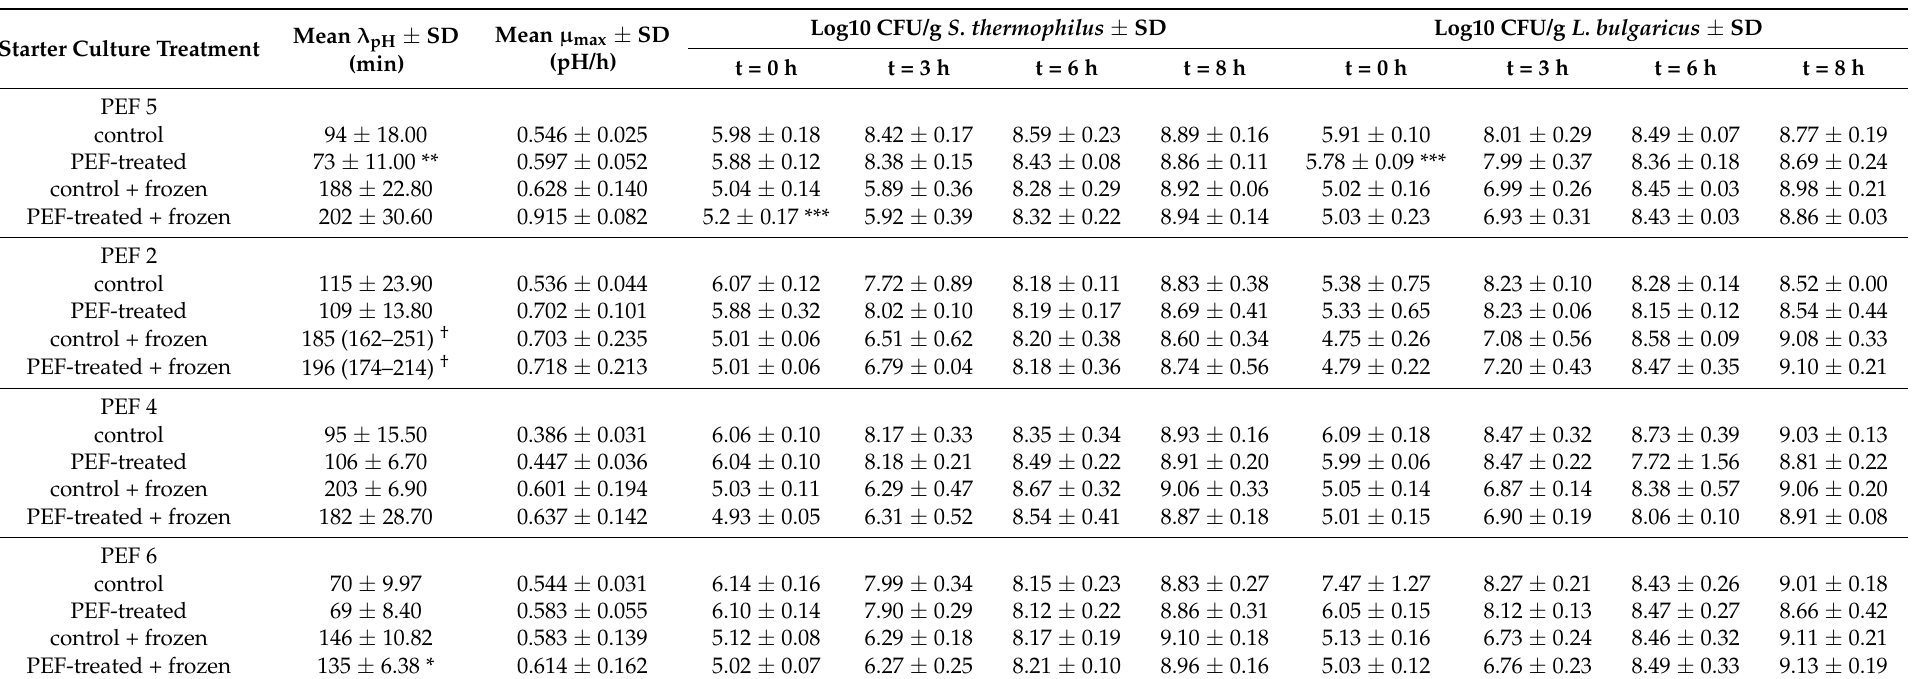
Table 3. pH lag phase ( λ pH ), maximum pH change rate ( µ max ) and development of the cell counts of S. thermophilus and L. delbrueckii subsp. bulgaricus in yogurts made in with PEF-treated and non-PEF-treated cells (control), with (frozen) and without a subsequent freeze–thaw cycle ( n =